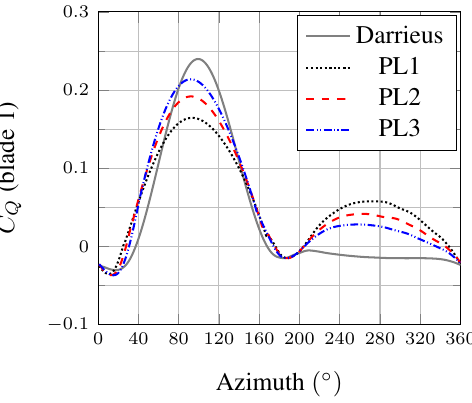
Figure 12. Torque coefficient ( C Q ) of one blade for the Darrieus and the pitching law cases, λ = 3.